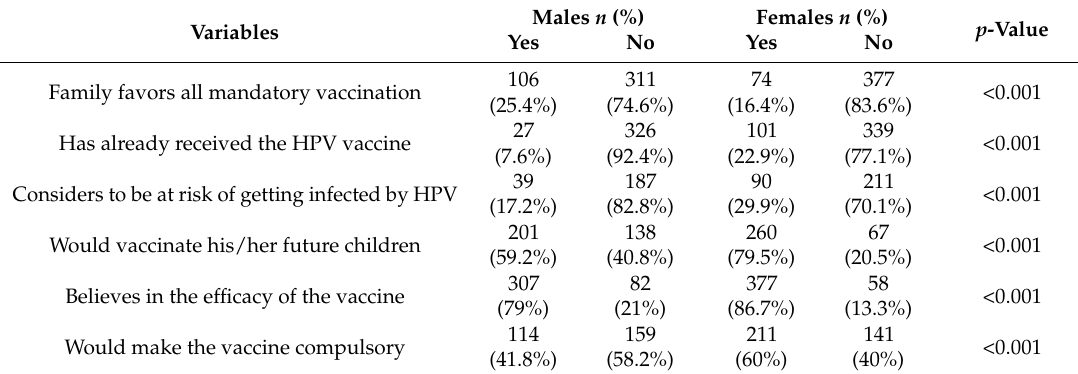
Table 9. Gender-based attitudes toward HPV